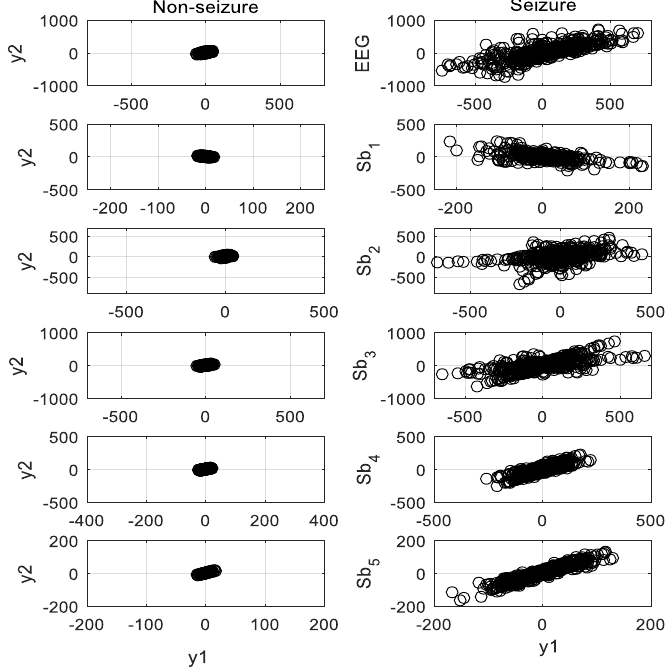
Figure 4. Second-order difference plot (SODP) of five subbands obtained from nonseizure ( left ) and seizure ( right ) EEG signals.